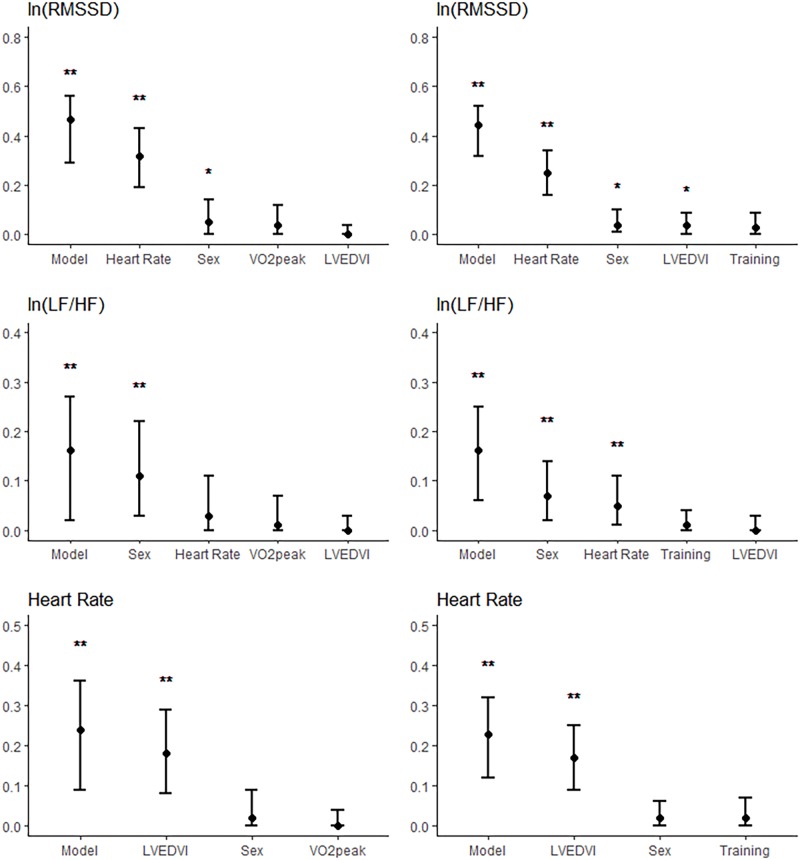
Semi-partial R2 of the models for ln(RMSSD) (Upper), ln(LF/HF) (Middle), and heart rate (Lower) when entering all predictors into the models. R2 of the complete models are also shown (“model”). Figures are shown for the models with VO2peak (Left) and weekly endurance training (Right) entered as exercise variables. The whiskers represent the 95% confidence intervals. ∗p < 0.05; ∗∗p < 0.01.